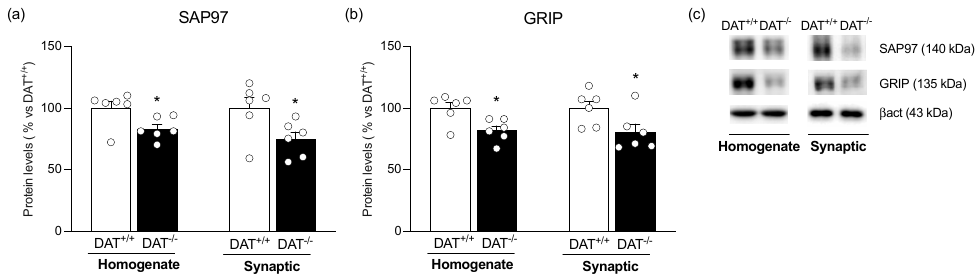
(SAP97 Figure 3a: Homo: − 17% vs. DAT +/+ , t = 2.485, p = 0.0323; PSD: − 25% vs. DAT +/+ , t = 2.362, p = 0.0398; GRIP Figure 3b: Homo: − 18% vs. DAT +/+ , t = 3.077, p = 0.0117; PSD: − 19% vs. DAT +/+ , t = 2.270, p = 0.0477).